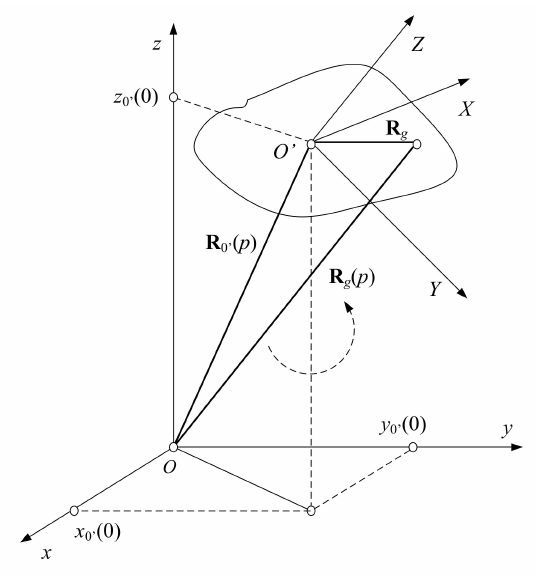
Figure 2. Inverse synthetic aperture radar (ISAR) scenario: asteroid’s kinematics and